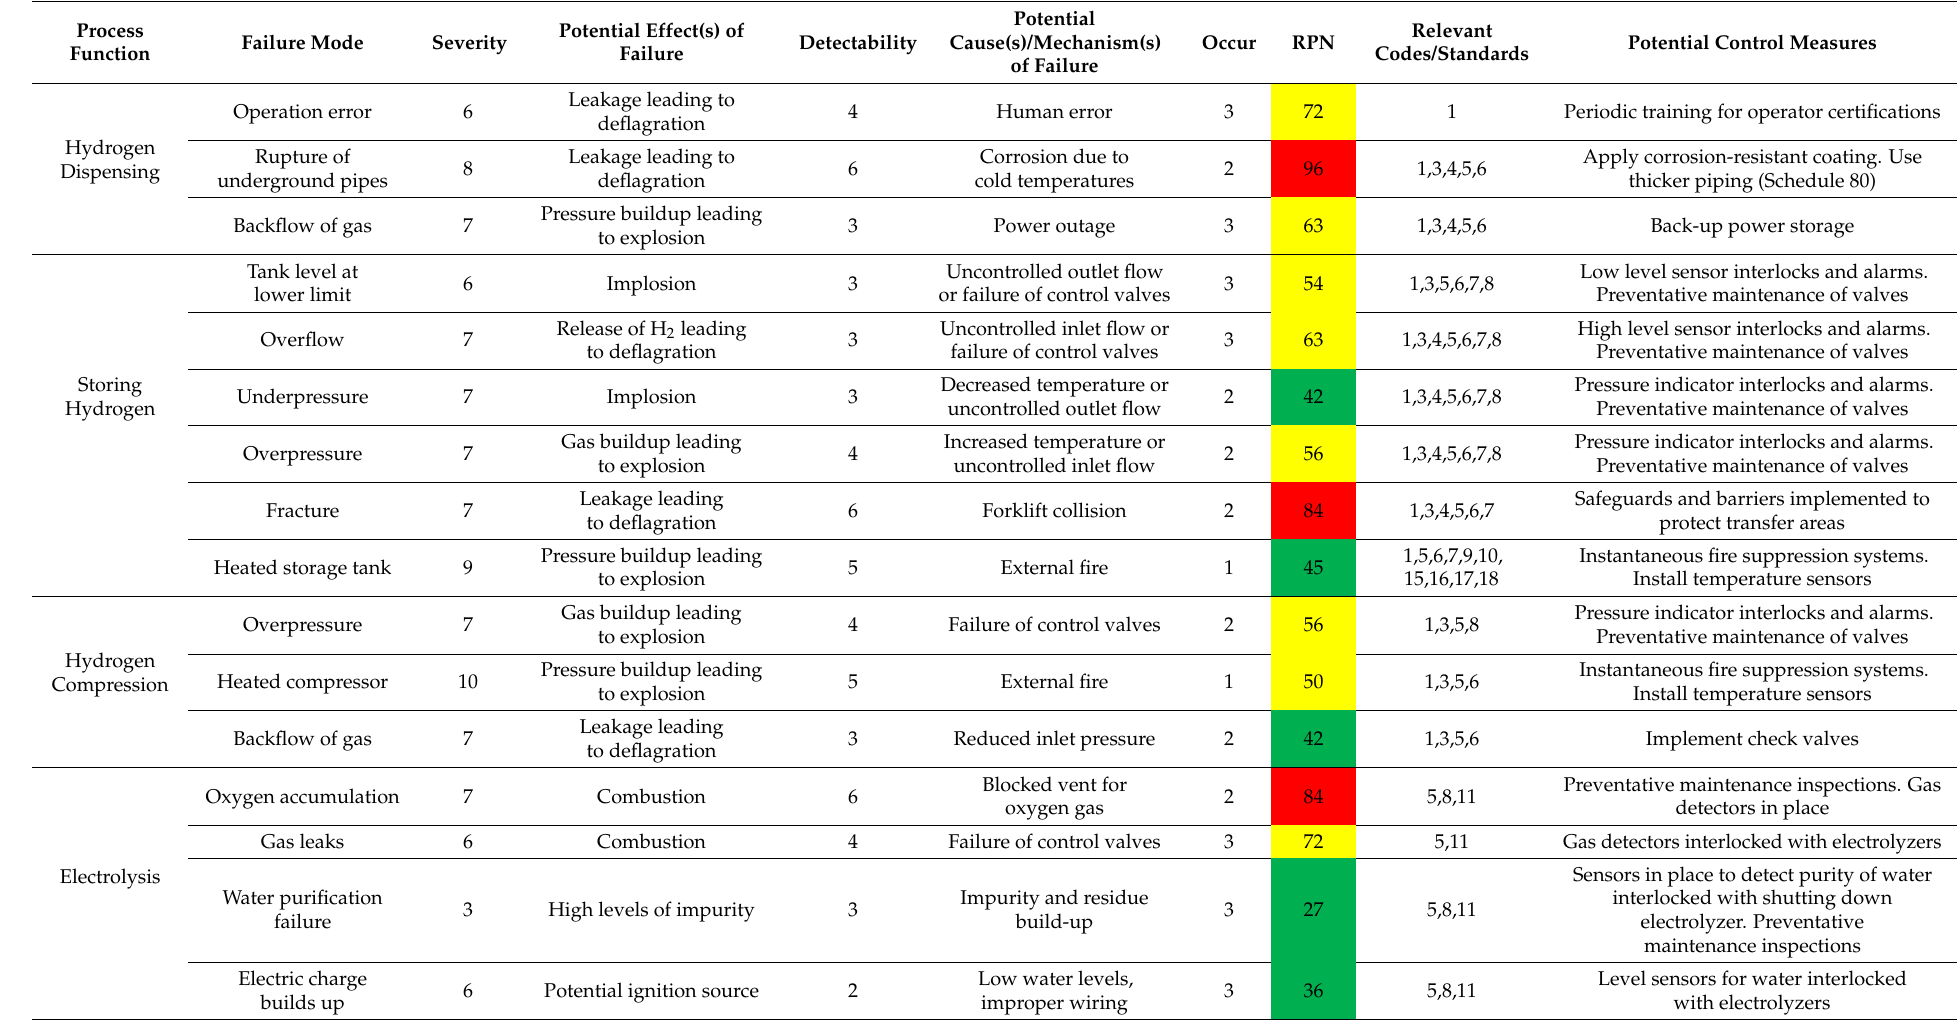
Table 2. Summary of the Failure Modes and Effects Analysis of the power-to-gas HENG system noting the potential control measures available to mitigate